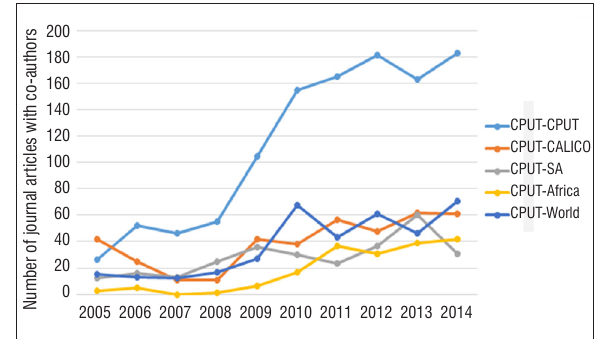
Figure 5: Growth in CPUT collaboration over a 10-year